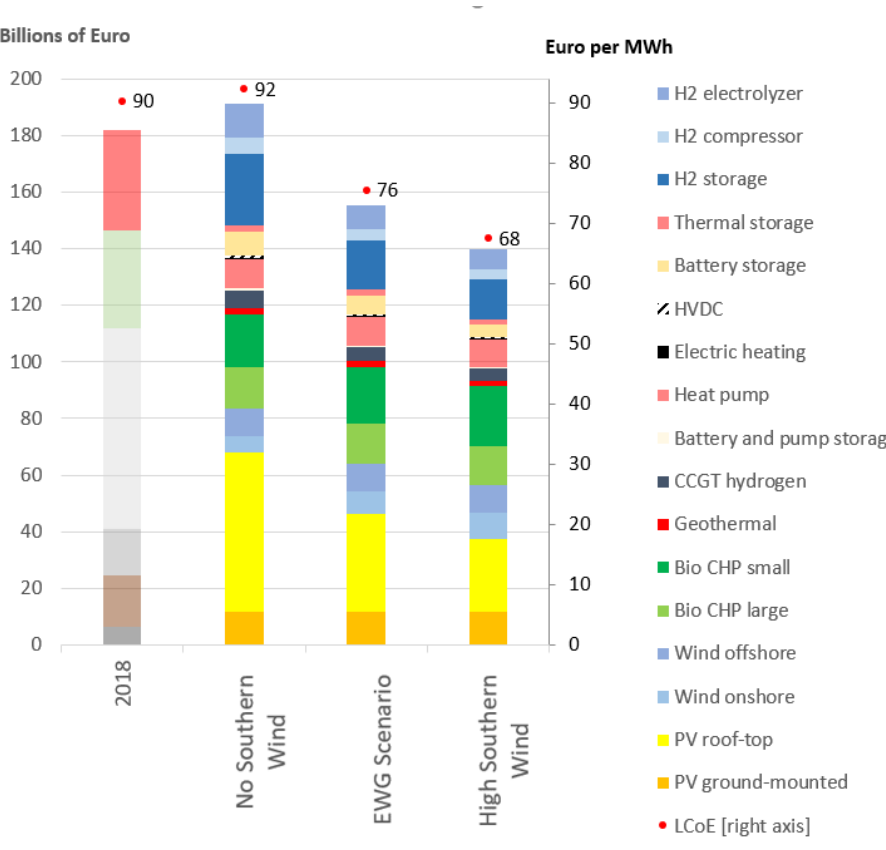
Figure 8. Annual energy system costs (left axis) and levelized costs of energy ( LCoE , right